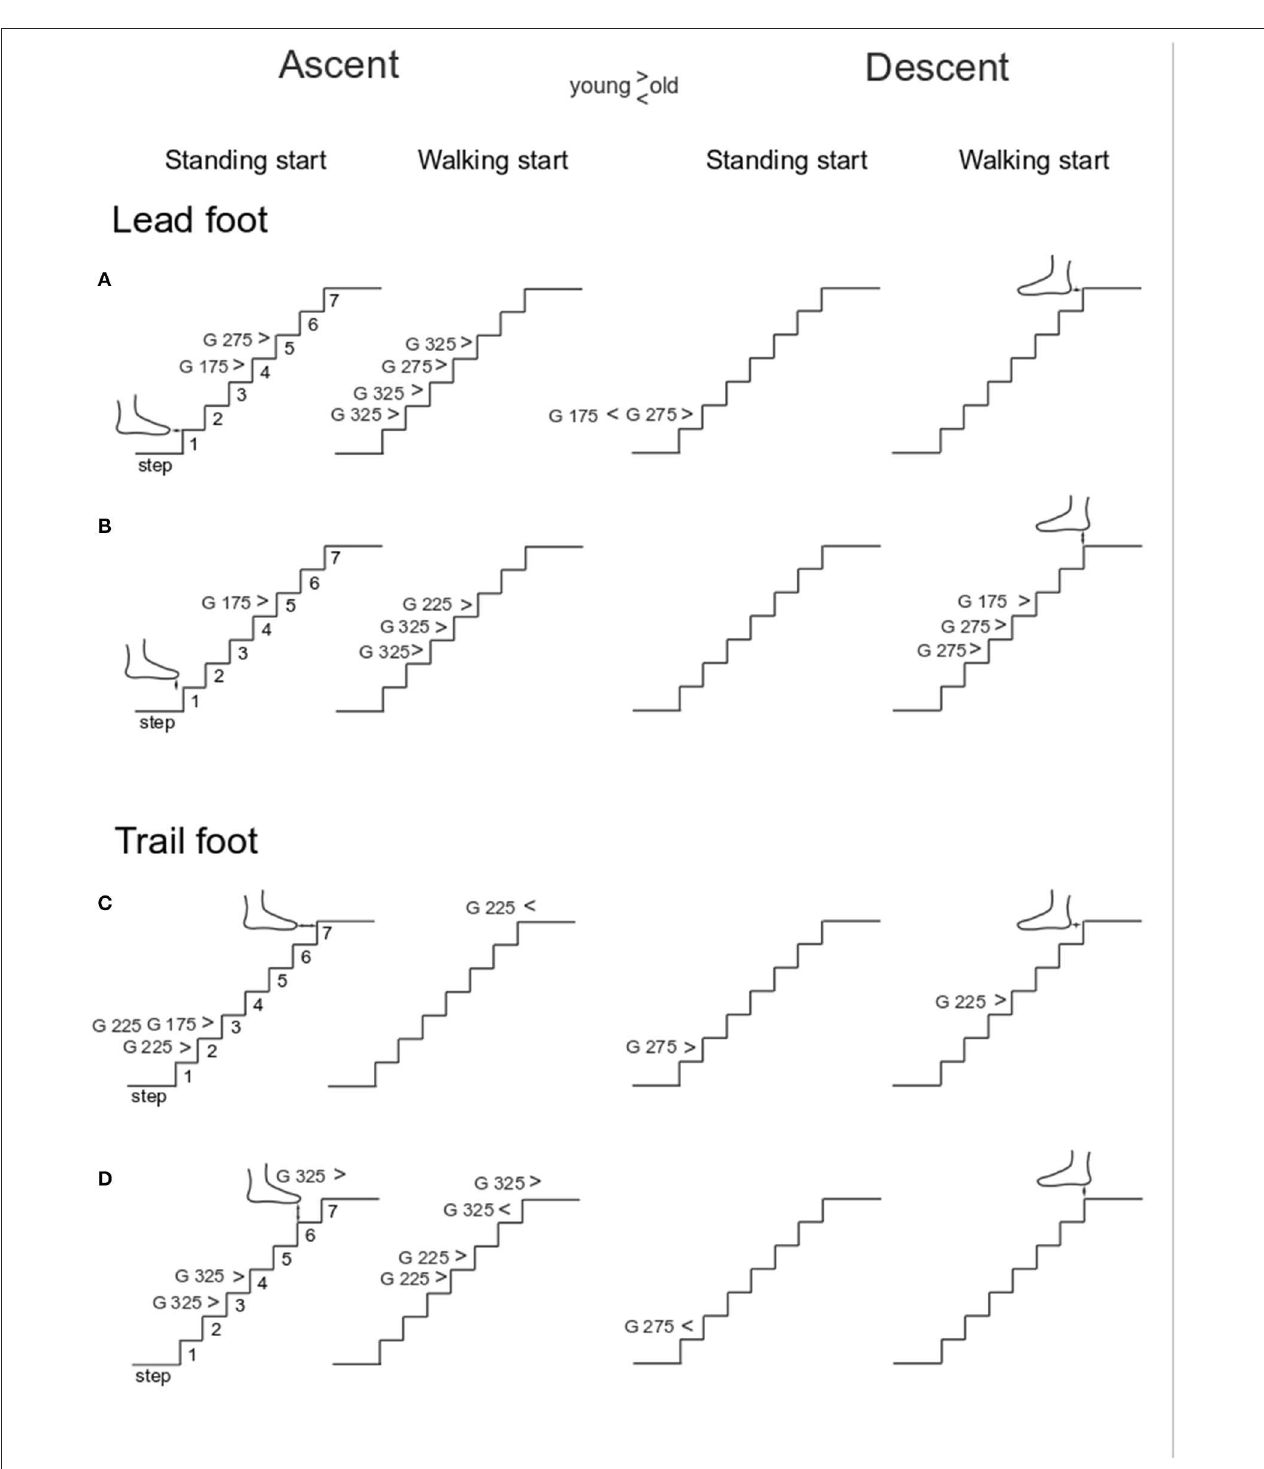
FIGURE 4 | Single step clearance. The group average of foot clearances was calculated for each step and an ANOVA test was run to find differences between younger and older groups for each step in each stair configuration. The results reported here are divided in four columns: ascent standing start, ascent walking start, descent standing start and descent walking start. For each panel, the significant difference ( p < 0.05) is reported with the indication of which going (G) showed the significant results and whether the younger group’s means was higher ( > ) or lower than older group’s mean ( < ). The four rows show: Lead foot clearance in horizontal (A) and vertical direction (B) ; trail foot clearance in horizontal (C) and vertical direction (D) .